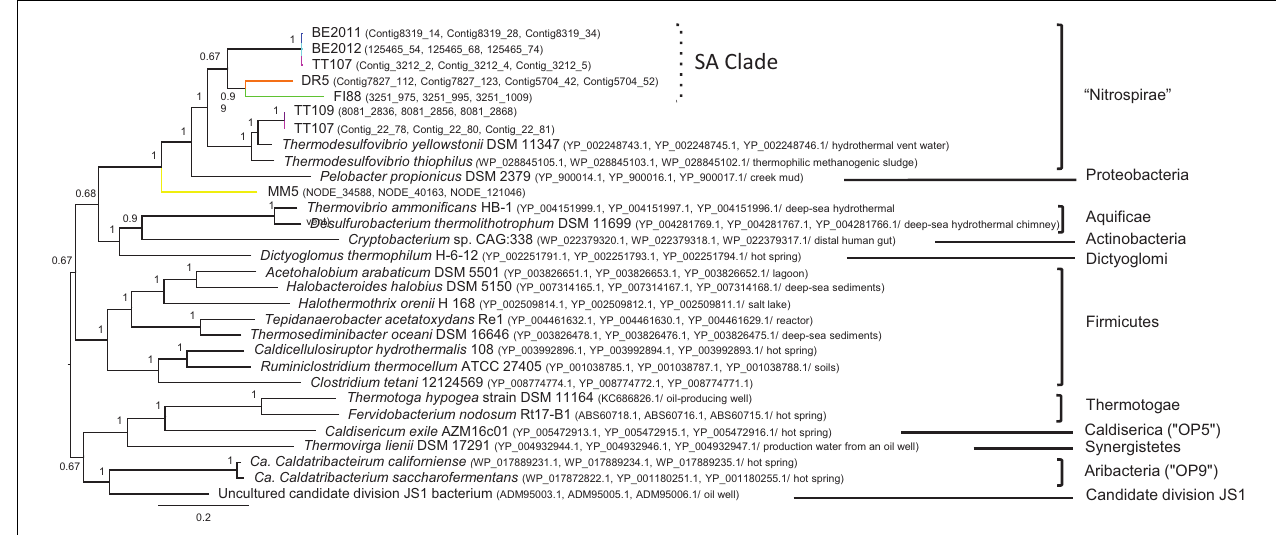
FIGURE 6 | Bayesian likelihood tree of deduced amino acid sequences of the Por C-AB operon. The same color scheme as in Figure 4 is used to highlight our sequences. Our metagenomes are followed by contig IDs, whereas reference taxa are suffixed by